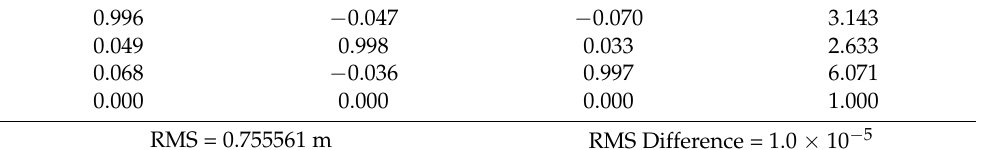
Table 2. Coordinate transformation matrix for the first rough registration of two complete point clouds.